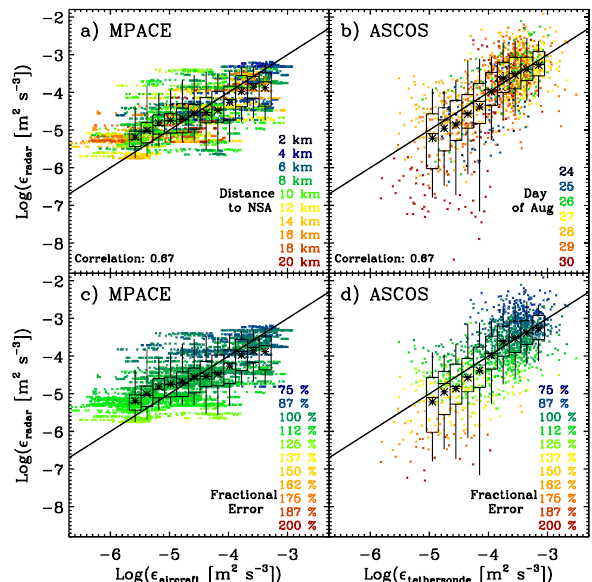
Fig. 6. Point-to-point comparisons of dissipation rate for all cases at ( a and c ) MPACE and ( b and d ) ASCOS. Statistics of the re- trieved data in bins of the in situ data are given as box-and-whisker plots that show the median (middle bar), 25th and 75th percentiles (ends of box), 5th and 95th percentiles (whiskers), and the mean as a symbol. Points in panel a are colored according to the horizon- tal distance between the aircraft observation and the vertical radar beam, points in panel b are colored according to the day of ob- servation during ASCOS, and points in panels c and d are colored according to the fractional error in dissipation rate calculated using Eq. (7). One-to-one lines are included in each panel.